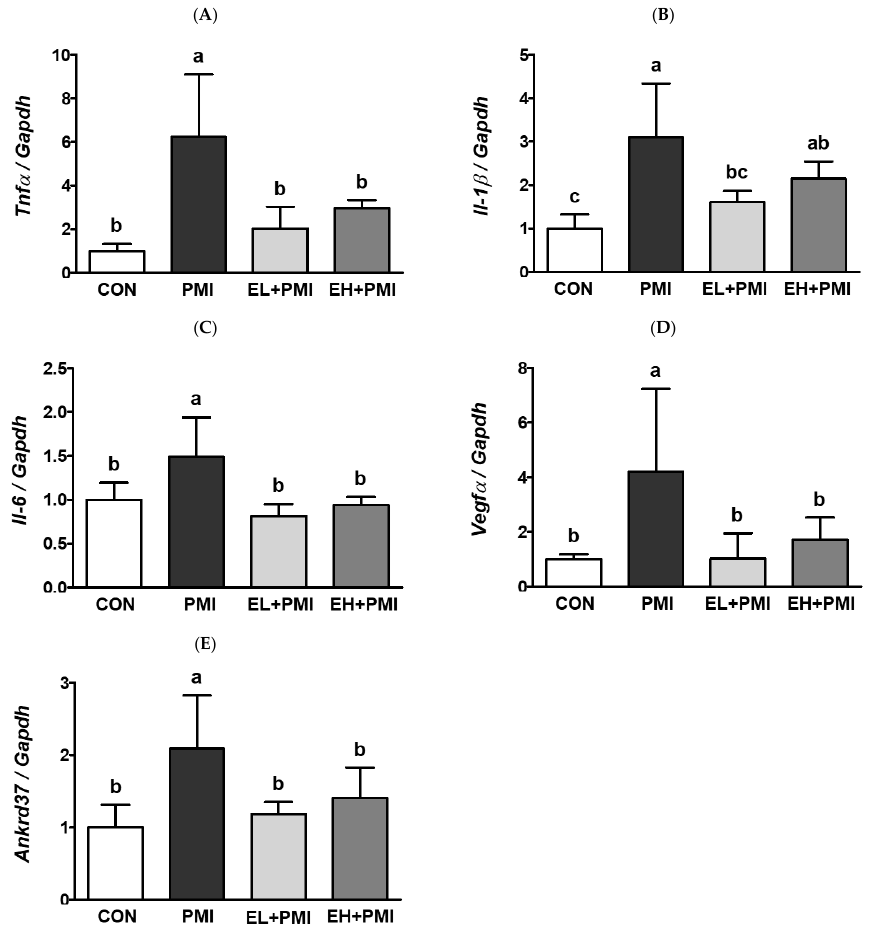
Figure 5. Pulmonary mRNA expressions after ellagic acid (EA) pretreatment and particulate matter (PM) instillation. C57BL/6 mice were orally pretreated with ellagic acid (EL; 20 mg/kg or EH; 100 mg/kg) for 7 days, and then PM (5 mg/kg) was intratracheally administrated for 7 days with or without ellagic acid pretreatment: ( A ) Tnfα , ( B ) Il- 1β , ( C ) Il-6 , ( D ) Vegfα , and ( E ) Ankrd37 expression was analyzed using qRT-PCR normalized to Gapdh mRNA expression. Values represent the mean ± standard deviation (SD) for each group ( n = 8). Data passed t he D’Agostino and Pearson omnibus normality test; one-way ANOVA wit h Tukey’s post hoc test was applied. Lowercase letters indicate significant differences. p < 0.05.